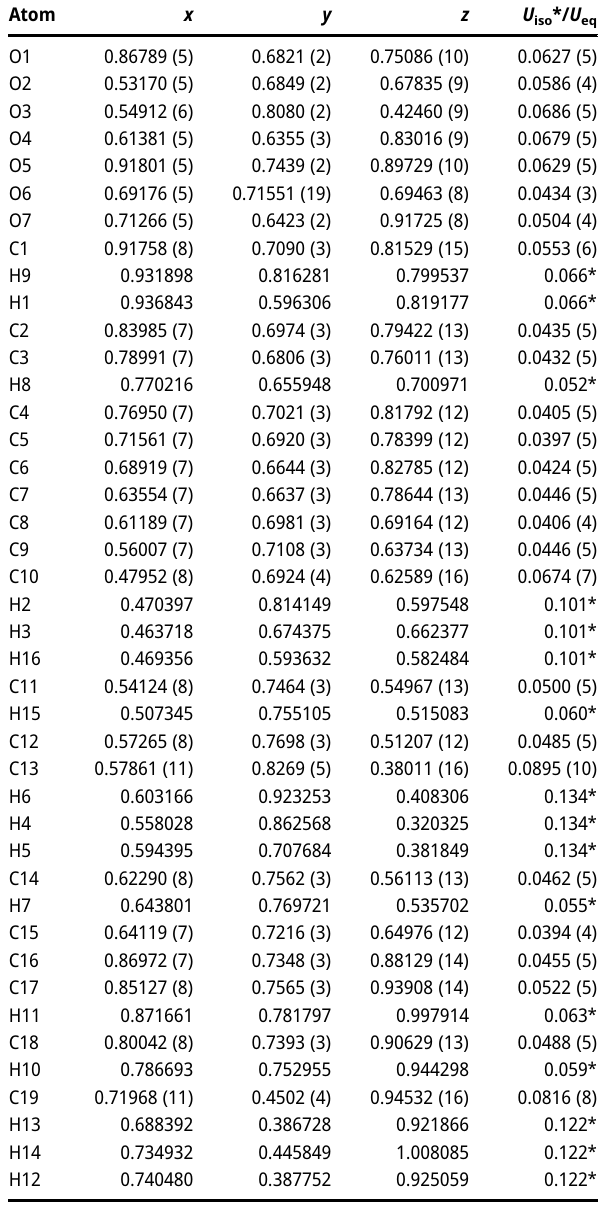
isotropic displacement parameters (Å 